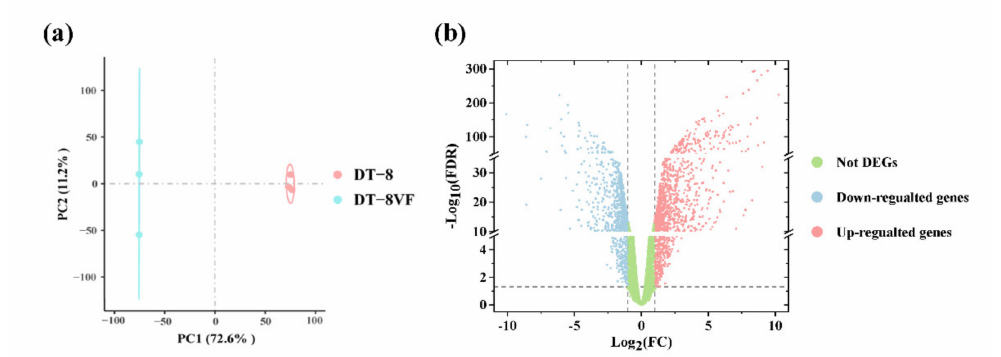
Figure 1. Transcriptome profile of digital RNA-Seq data. ( a ) The PCA for samples of strain DT-8 and strain DT-8VF. The blue and red ellipses display 95% confidence regions of samples of strain DT-8 and strain DT-8VF, respectively. ( b ) The volcano plot of digital RNA-seq data. A horizontal dotted line indicates significance cutoff and vertical lines indicate the differential expression magnitude